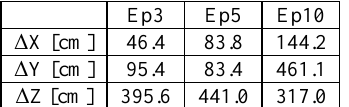
Table 1. CPs discrepancies results for epoch image